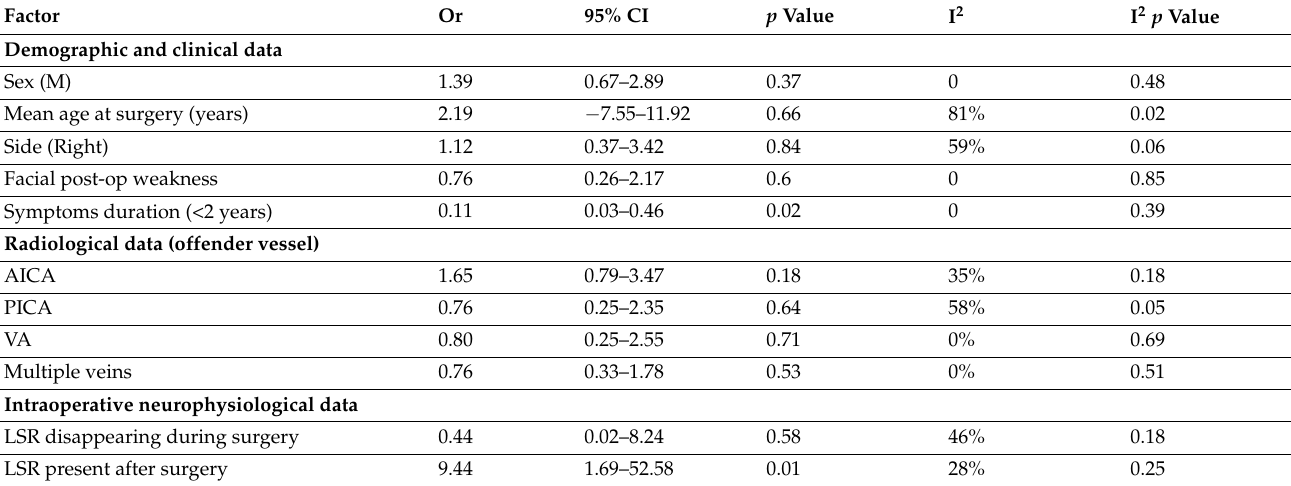
Figure 1. Systematic review flow diagram. The PRISMA flow diagram for the systematic review, detailing the database searches, the number of abstracts screened, and the full text. Table 2. Meta-analysis of possible factors involved in hemifacial spasm